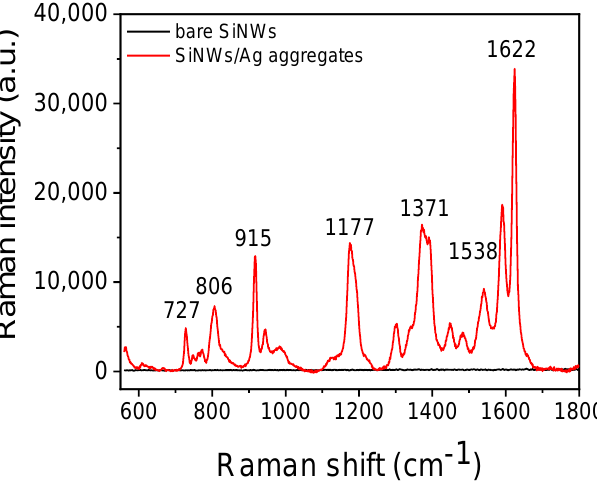
Figure 2. SERS spectra received from surfaces with bare SiNWs (black line) or SiNWs decorated with Ag nanoparticles after incubation with a 30 μ g/mL aqueous CV solution using a laser at 532 nm.